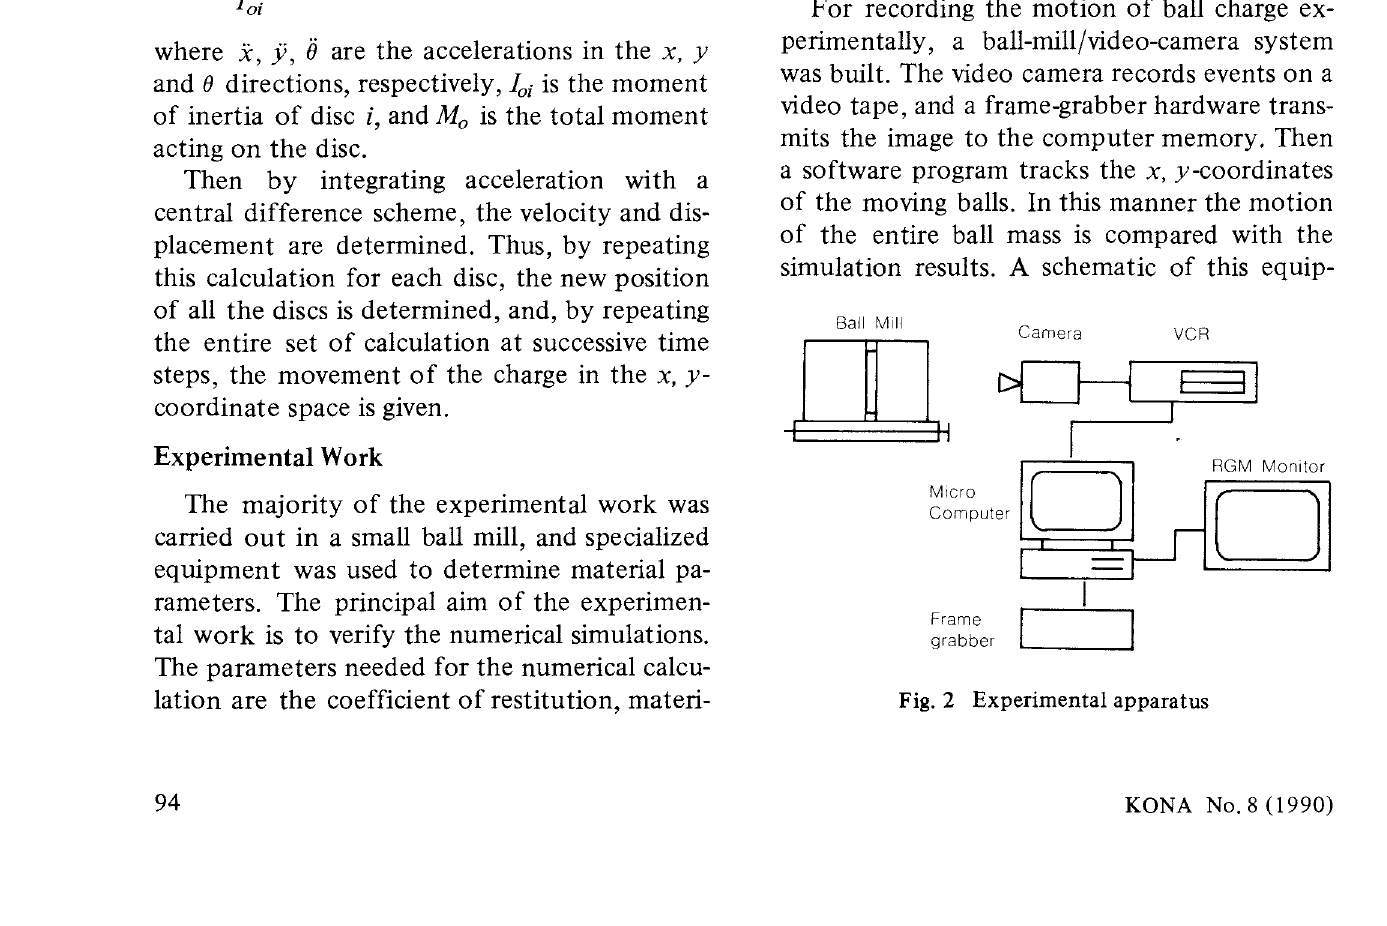
Fig. 2 Experimental apparatus